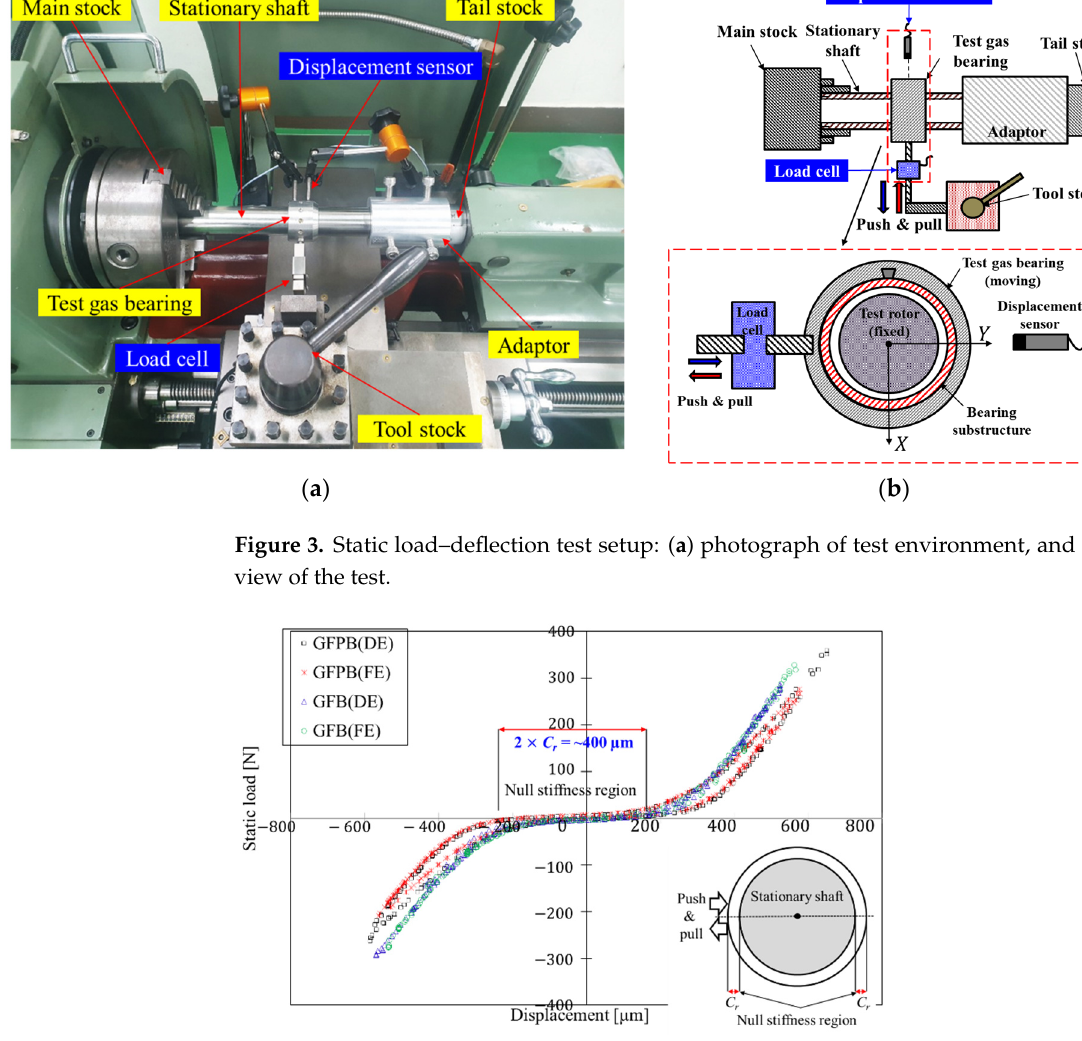
Figure 3. Static load–deflection test setup: ( a ) photograph of test environment, and ( b ) schematic view of the test.